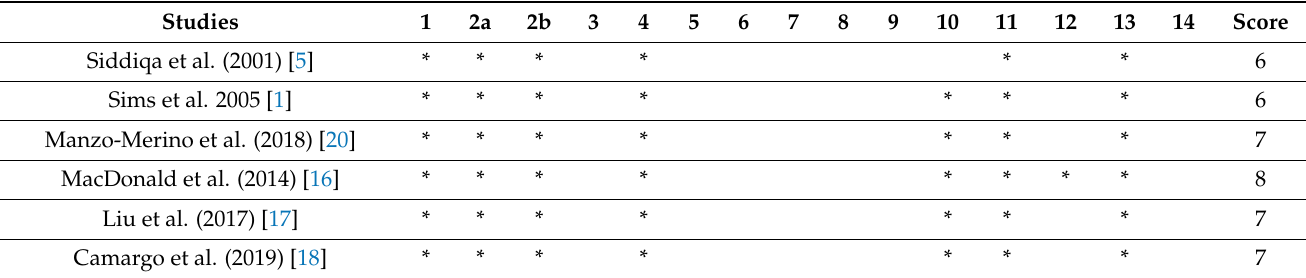
Table 3. Quality of articles assessed with the modified CONSORT scale for in vitro studies.